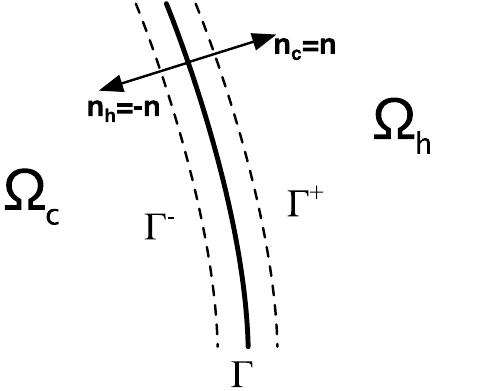
Figure 4. Orientation of the interface between the cloak domain (cid:31) c and host domain (cid:31) h